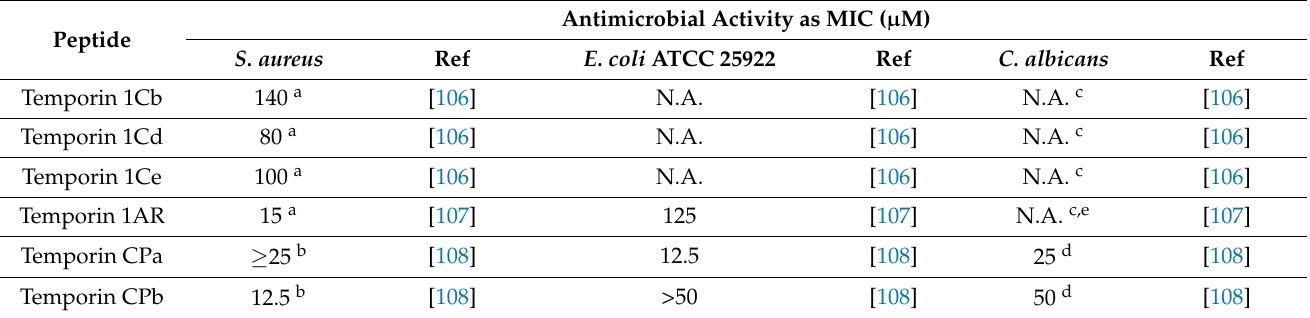
Table 8. Antimicrobial activity against selected microorganisms of temporins from Lithobates . Antimicrobial Activity as MIC ( µ M) Peptide S.